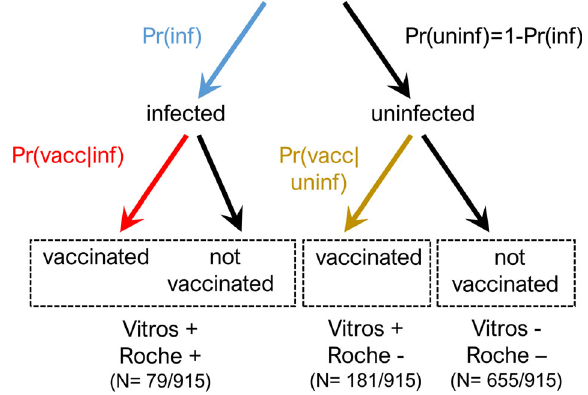
Fig. 2 Schematic of parameters to be estimated using serosurveillance platform (shown in red, blue and gold). Red represents the probability of vaccination given prior infection, Pr(vacc|inf), blue represents the probability of prior infection, Pr(inf), and gold represents the probability of vaccination given no prior history of infection,